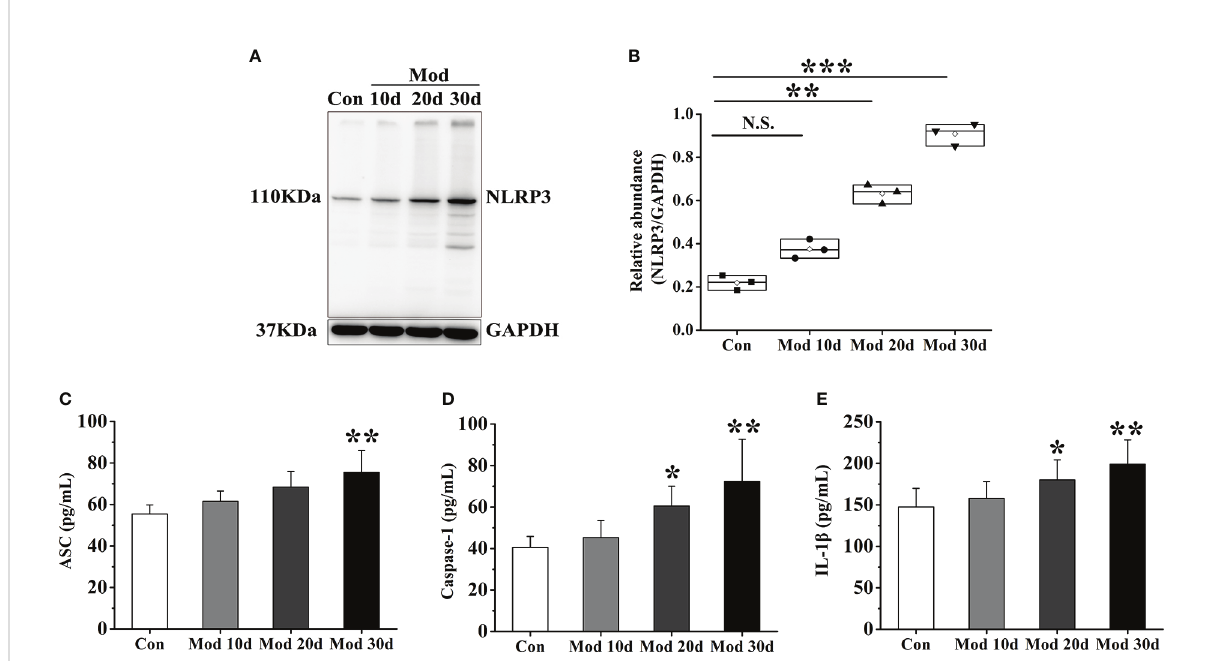
FIGURE 2 As the experiment progressed, the NLRP3 in fl ammasome was activated and IL-1 b expression increased in synovial tissue. (A) Western blot was conducted to evaluate the protein level of NLRP3 and GAPDH in synovial tissue (n=3). (B) Box plot showing the densitometry analysis of NLRP3 normalized by GAPDH. (C) The expression level of ASC in synovial tissue. (D) The expression level of Caspase-1 in synovial tissue. (E) The expression level of IL-1 b in synovial tissue. Data are expressed as mean ± SEM for 8 quails in each group. * P < 0.05, ** P < 0.01 and *** P < 0.001 versus Con